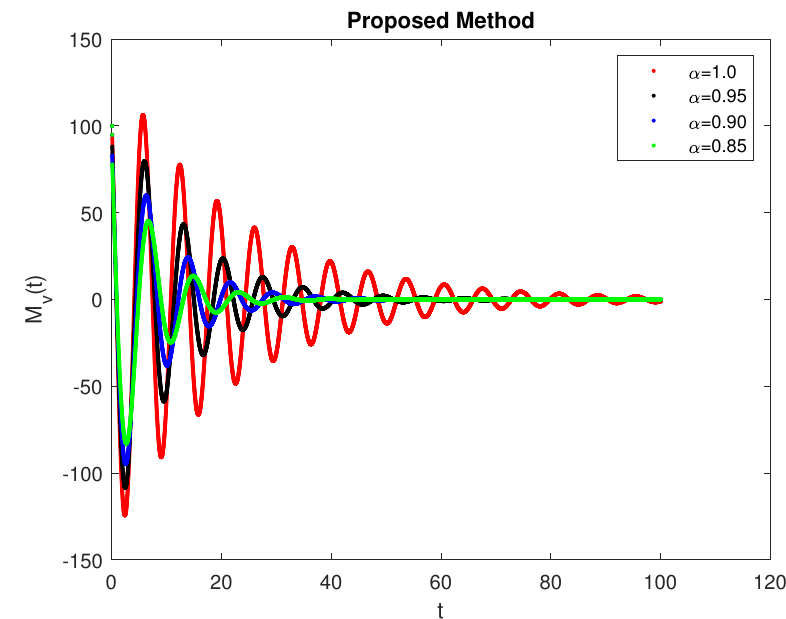
Figure 23: Numerical simulations for τ = 0.98 for Caputo-Fabrizio derivative.